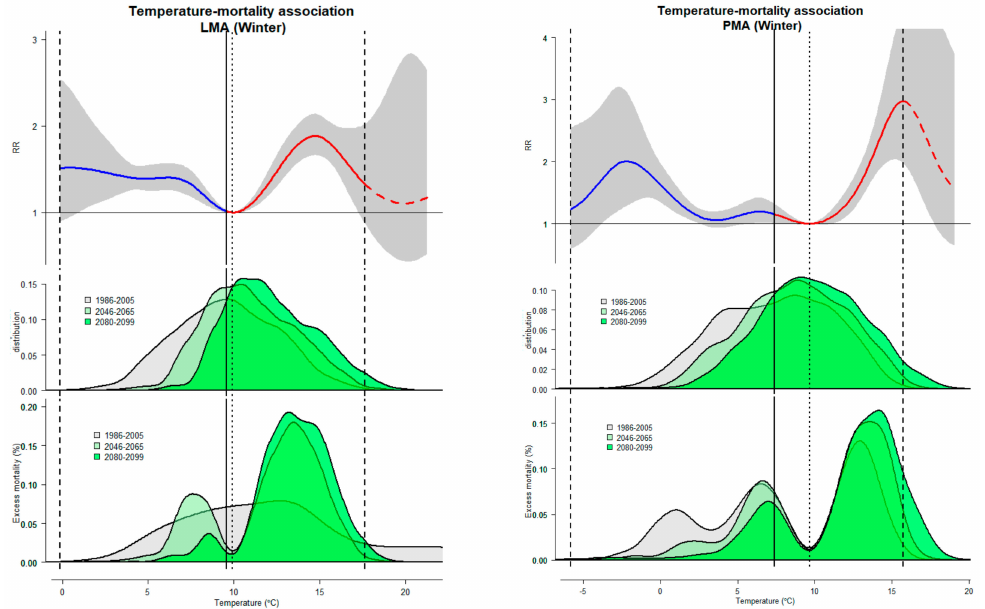
Figure 6. Temperature and excess mortality for the historical and future periods in the study region during the winter period. Top panel: Exposure–response curve for temperature–mortality relative risk (RR), with the blue and red lines representing cold and hot, respectively, together with their 95% CI in grey. The solid vertical line corresponds to the mean temperature that divides the curve into cold and hot, while the dotted represents the reference temperature (MMT). The dashed red line represents the extrapolation beyond the maximum temperature in 1986–2005 (broken vertical line) for the future periods. Middle panel: Temperature distribution for the historical (grey area) and future periods, 2046–2065 (green area) and 2080–2099 (darker green area). Bottom panel: Temperature-related excess mortality distribution expressed as the fraction of additional deaths (%) attributed to non-optimal temperature, compared with the reference